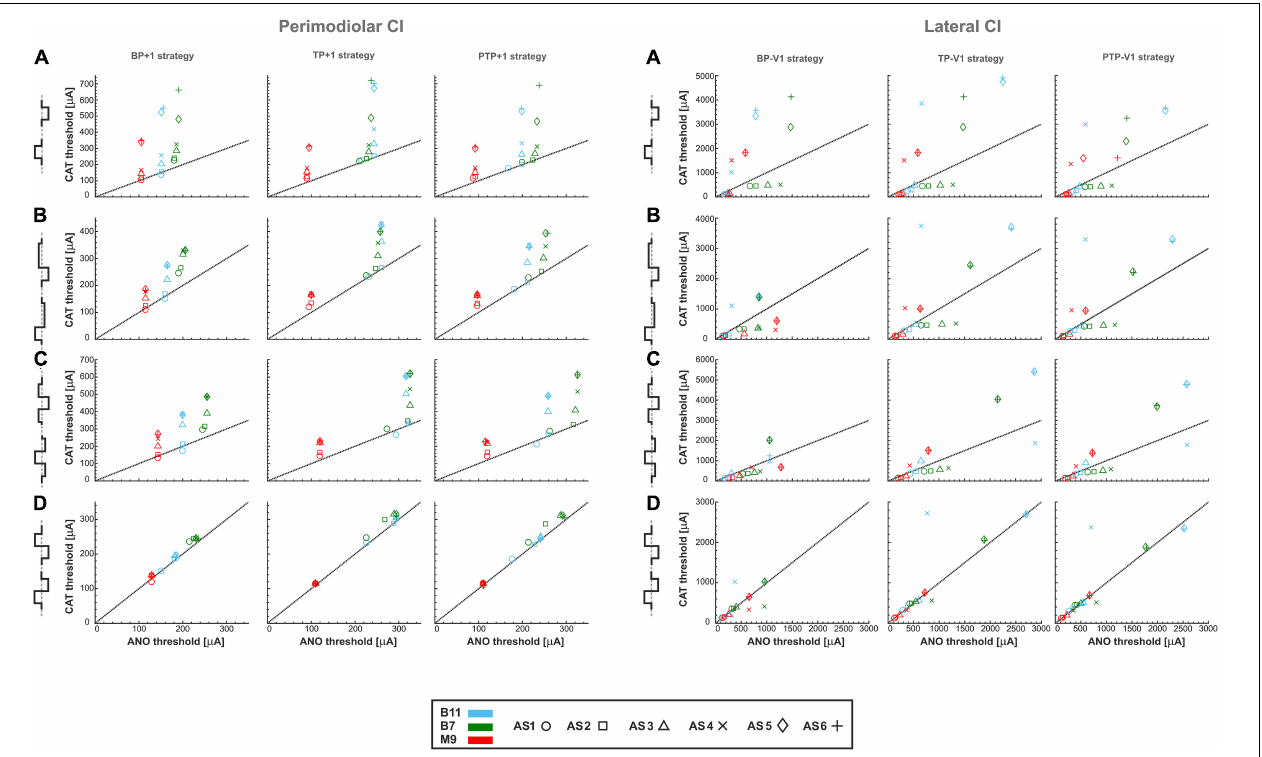
FIGURE 12 | Threshold of three TNs for perimodiolar CI (left panel) and lateral CI (right panel) for four different pulse types and three multipolar strategies by changing the distance between channels of both CI systems. (A) monophasic, (B) pseudomonophasic, (C) triphasic, and (D) biphasic pulse. Layout as in Figure 4